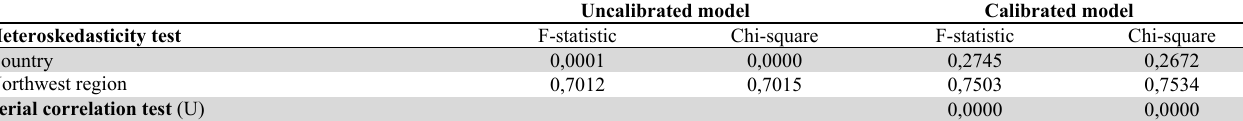
Results of Heteroskedasticity and serial correlation